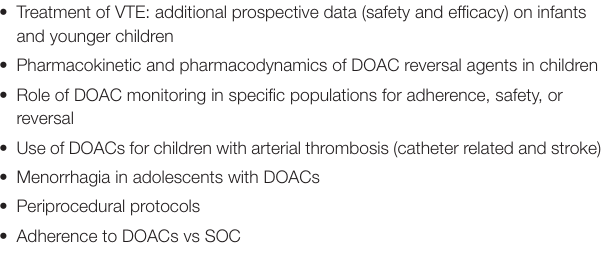
TABLE 1 | Priorities for additional research regarding use of DOACs in children.